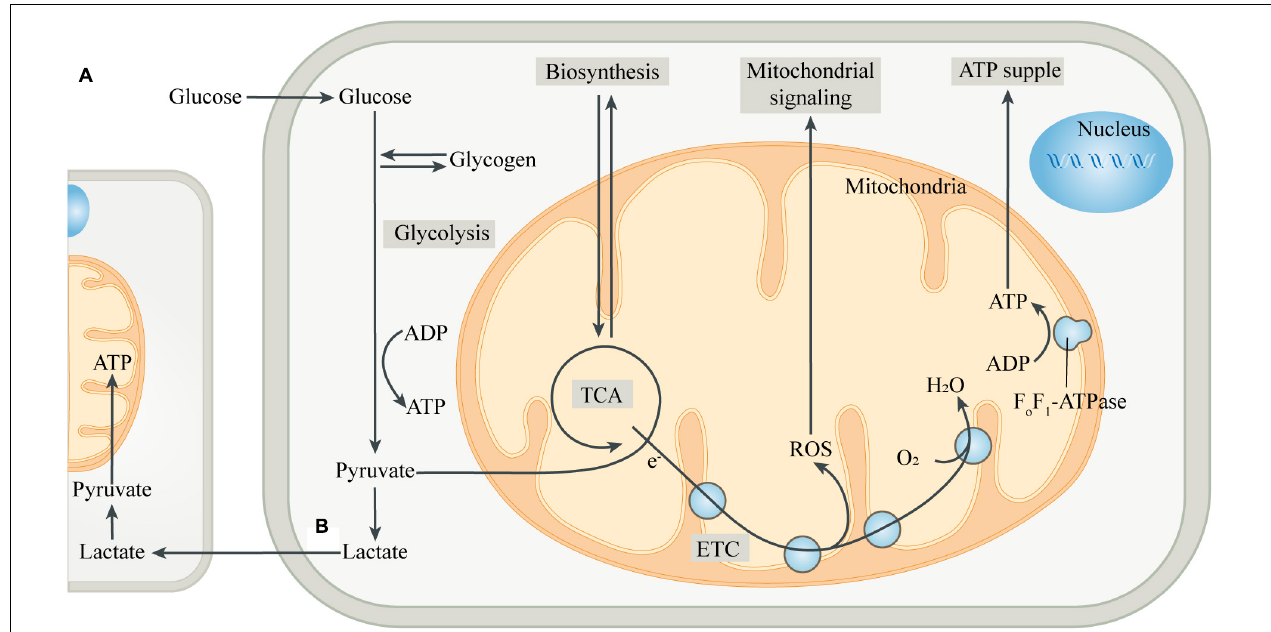
FIGURE 1 | Intracellular metabolic coupling and intercellular metabolic cooperation. (A) The coupling of glycolysis of the cytoplasm with aerobic metabolic processes of mitochondria constitutes the center of cellular energy metabolism. Meanwhile, mitochondria provide many substrates for cell anabolism, and the by-products produced by mitochondria are important signaling substances. (B) Pyruvate, produced by glycolysis, is partially converted to lactate, which is then released into the extracellular space and ingested by adjacent or distant cells. After entering the cell, lactate is converted to pyruvate, which is then transferred into the mitochondria and is oxidized by mitochondria for energy, thus completing the metabolic cooperation between cells. Abbreviations: ETC, electron transport chain; TCA, tricarboxylic acid